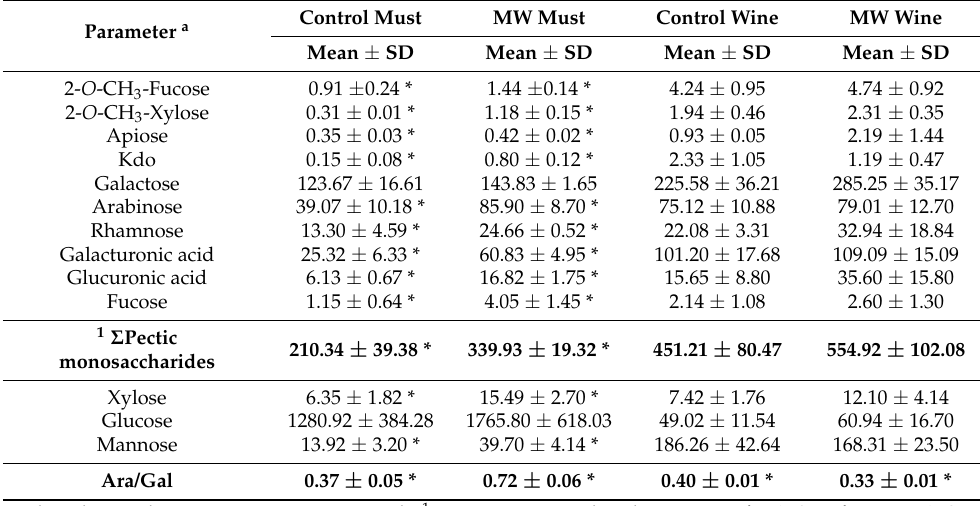
Table 5. Monosaccharide composition (mg/L) of polysaccharides in musts and wines (control samples and samples from microwave